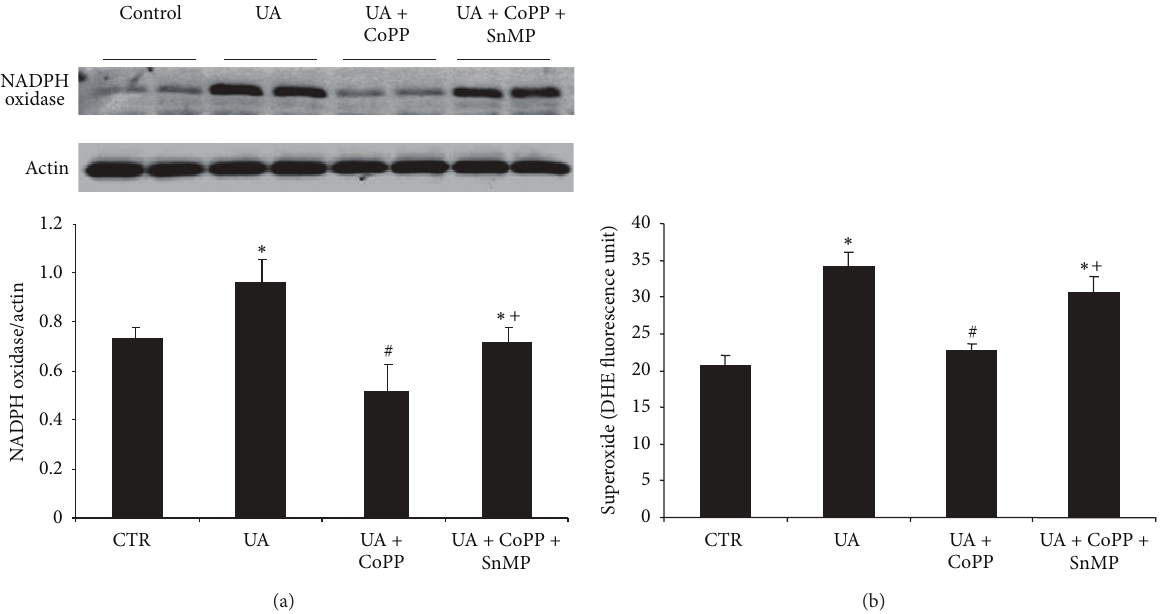
Figure 6: (a) NADPH oxidase expression by western blot analysis. Data are shown as mean band density normalized to 𝛽 -actin. Results are means ± SE, 𝑛 = 4 /group. ∗ 𝑝 < 0.05 versus CTR; # 𝑝 < 0.05 versus UA; and + 𝑝 < 0.05 versus UA + CoPP. (b) Measurement of superoxide levels in pelleted cells at day 14 of adipogenesis in human MSCs treated with 5 mg/dL uric acid with or without CoPP, in the presence or absence of SnMP. Values represent means ± SEM of five independent treatments. ∗ 𝑝 < 0.05 versus CTR; # 𝑝 < 0.05 versus UA; and + 𝑝 < 0.05 versus UA +